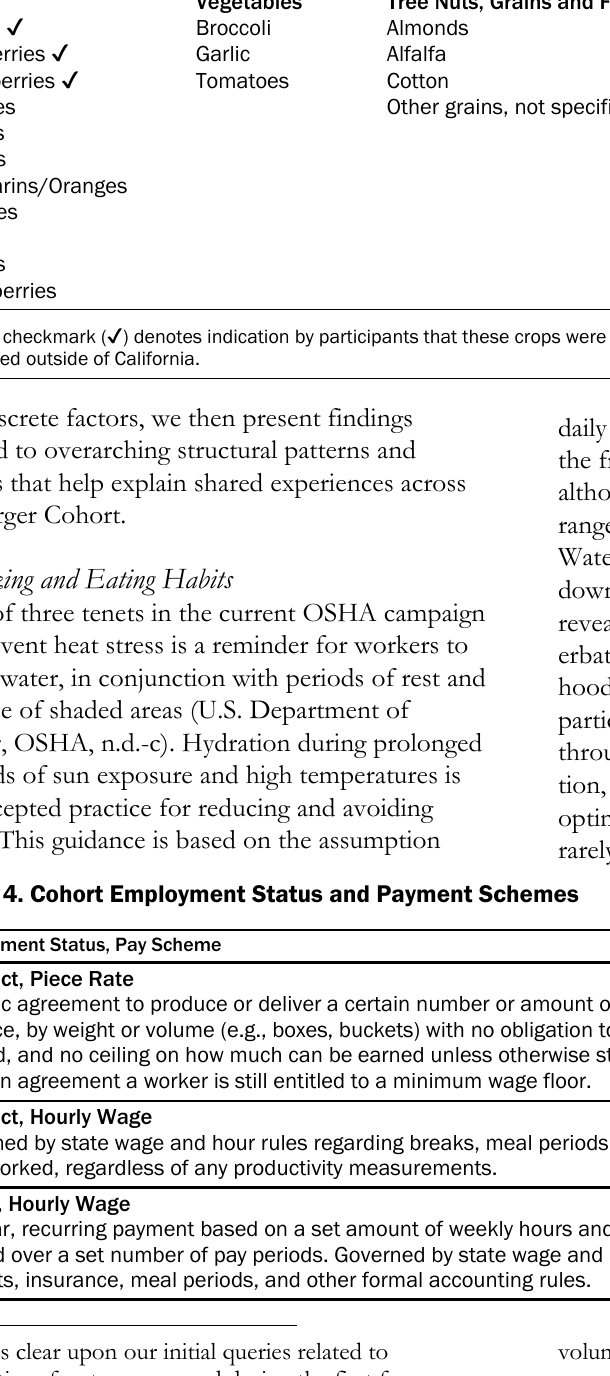
Table 3. Participant Crop and Harvest Experience Identified Crops Fruit